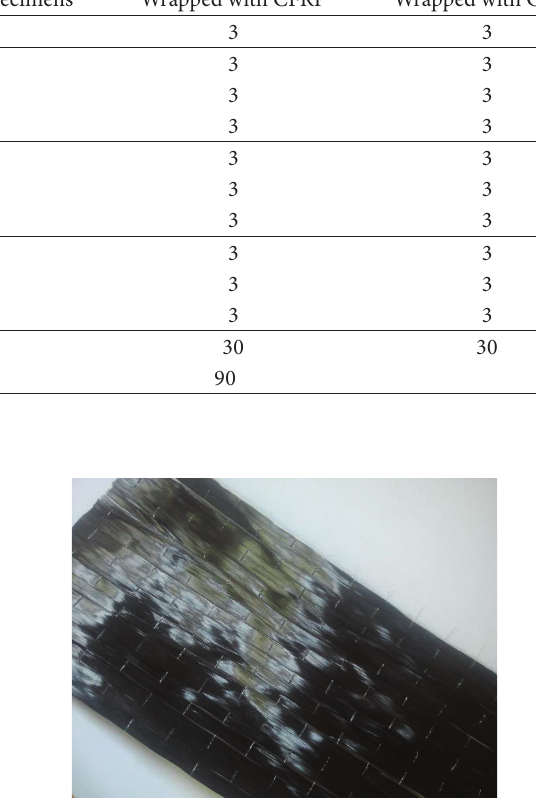
Figure 1: CFRP sheet sample.